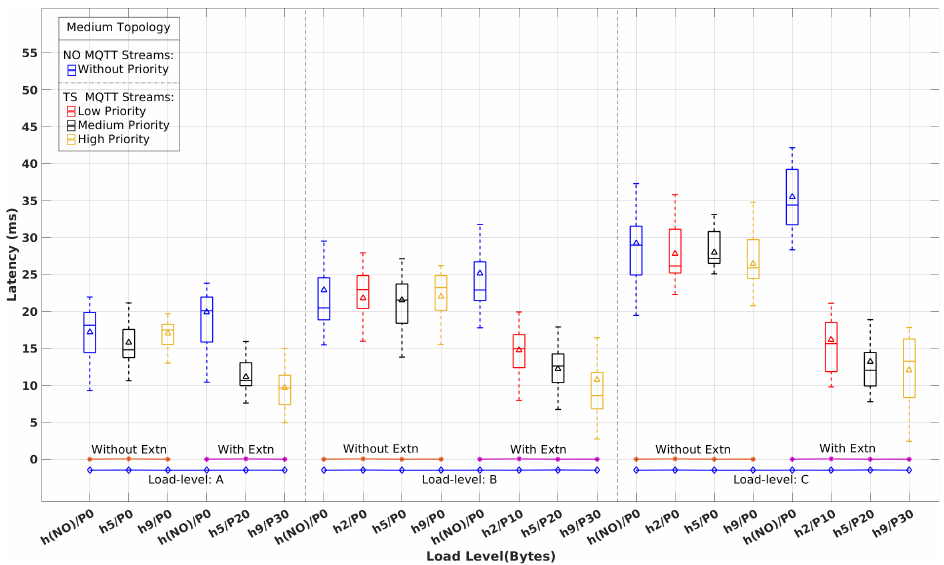
Figure 9. Latency of time-sensitive vs. normal MQTT flows with and without real-time extensions for the Medium topology and load levels A, B, and